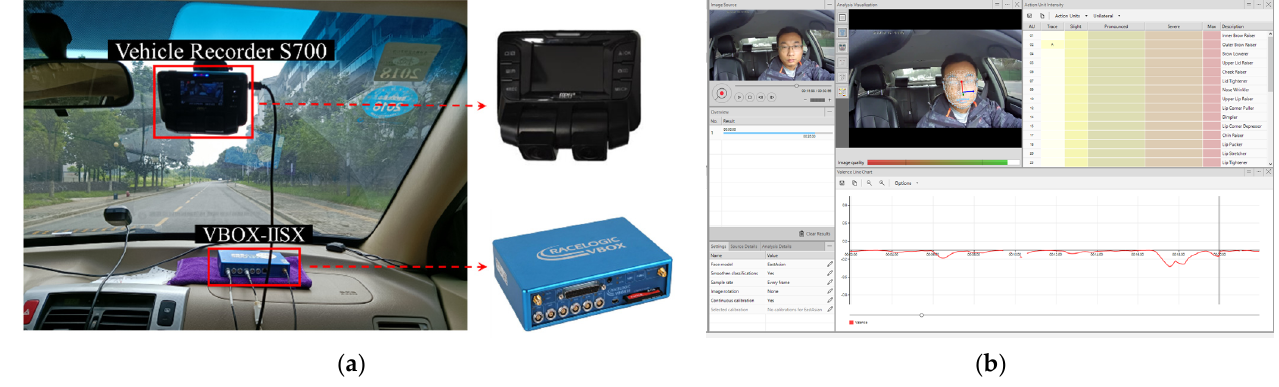
Figure 1. Test equipment. ( a ) In-vehicle equipment, ( b ) FaceReader 8.0. The data were collected over 12 days from the end of 2018 to early 2019 and consisted of 3,120,578 pieces of vehicle kinematic data and 905.5 GB of video clips. The vehicle kinematic data contained 12 features, which are described in Table 1. The video clip data include the information from outside ambient videos and driver videos.